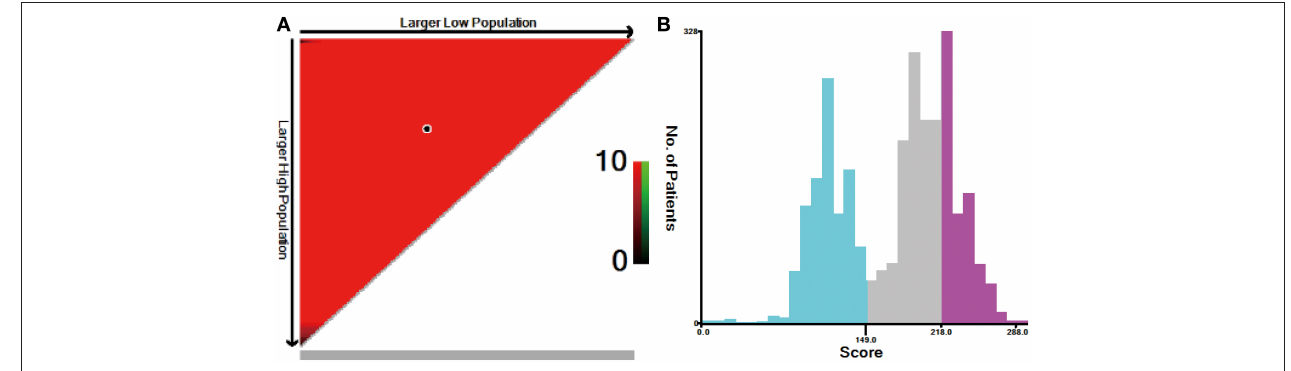
FIGURE 5 | X-tile analysis for risk stratification: (A) The optimal cutoff value; (B) Numbers of patients in low-, moderate-, and high-risk subgroups.